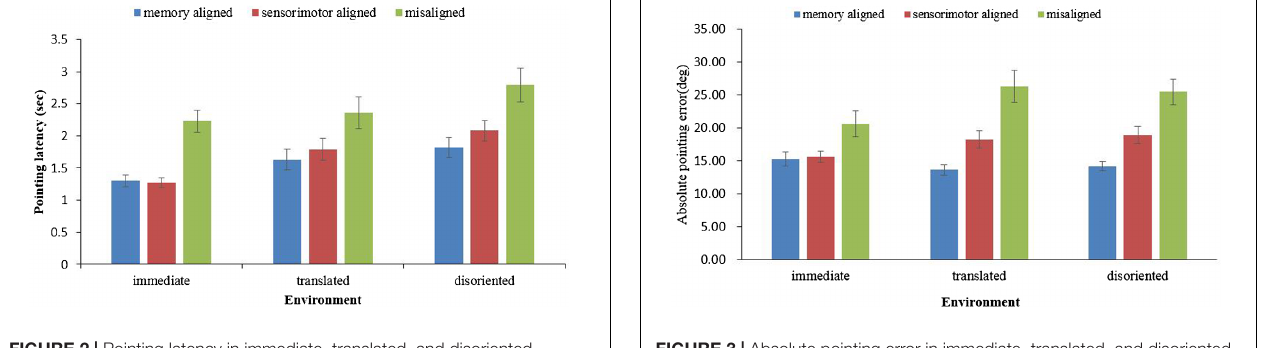
FIGURE 2 | Pointing latency in immediate, translated, and disoriented environments, as a function of imagined perspective. Error bars are confidence intervals corresponding to ± 1 SEM.